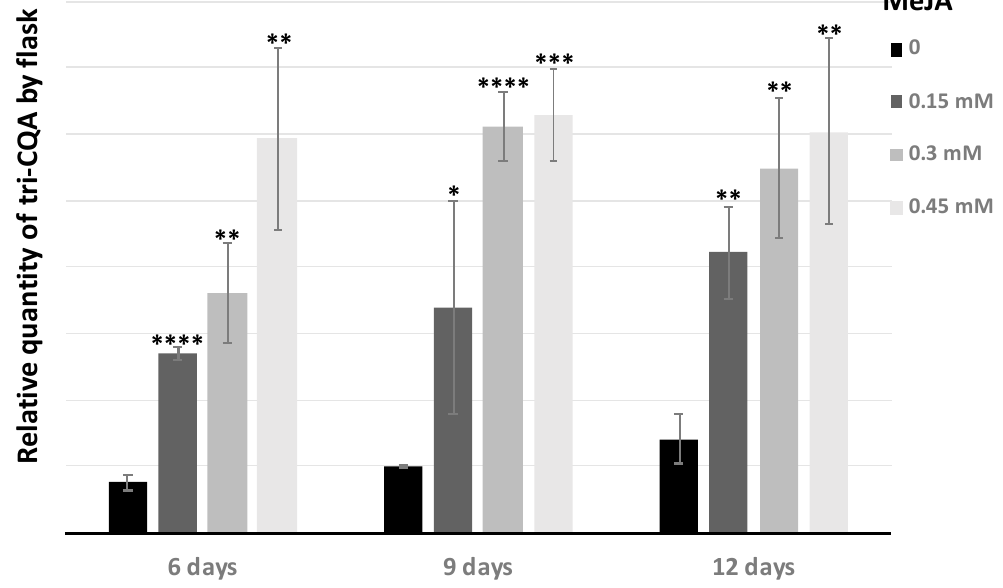
Figure 6. MeJA inhibitory effect on the production of 3,4,5-tricaffeoylquinic acid (tri-CQA) per flask. 0; 0.15; 0.3; 0.45 mM of MeJA indicates MeJA concentration of the culture medium. 6; 9; 12 days represents the duration of elicitation. Statistics were achieved by a two-tailed t test using Prism GraphPad online tool (https://www.graphpad.com/quickcalcs/ttest1/). The mean with SD were calculated and plotted. **** p < 0.0001; *** p = 0.0001 to 0.001; ** p = 0.001 to 0.01; * p = 0.01 to 0.05; NS (Not Significant), p ≥ 0.05. All the conditions were compared to the control condition 0 mM MeJA.